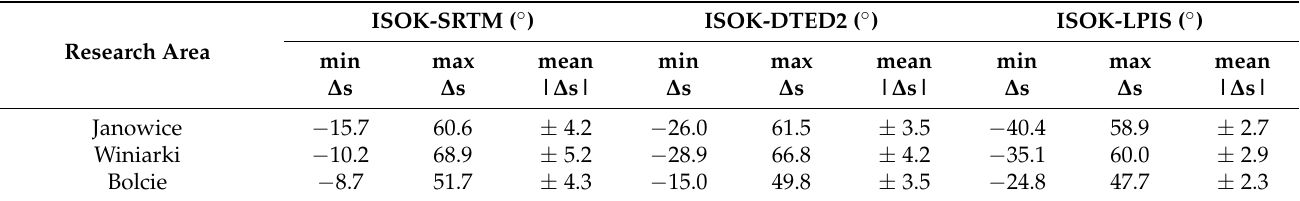
Table 9. Comparison of differences in the values of the terrain slopes ( ∆ s) ( ◦ ) calculated on the basis of DTM (SRTM, DTED2 and LPIS) against ISOK (minimum, maximum and the mean of the absolute value | ∆ s| of the differences) in the 3 research